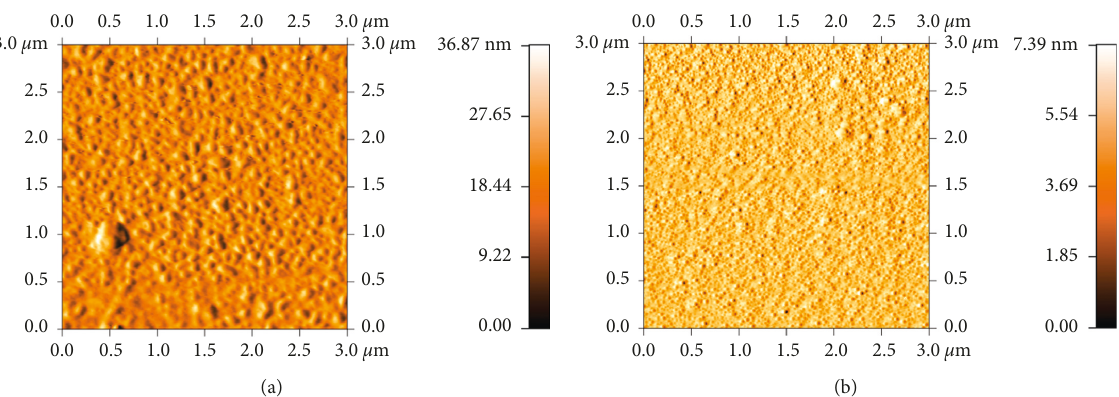
2 O 3 films deposited on polished Cu foil (a) after bombarding with Ar ion and (b)